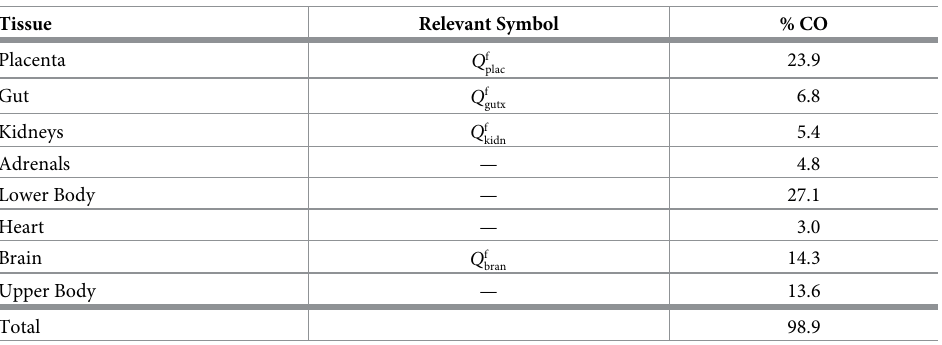
Table 29. Average blood flow rates to various fetal